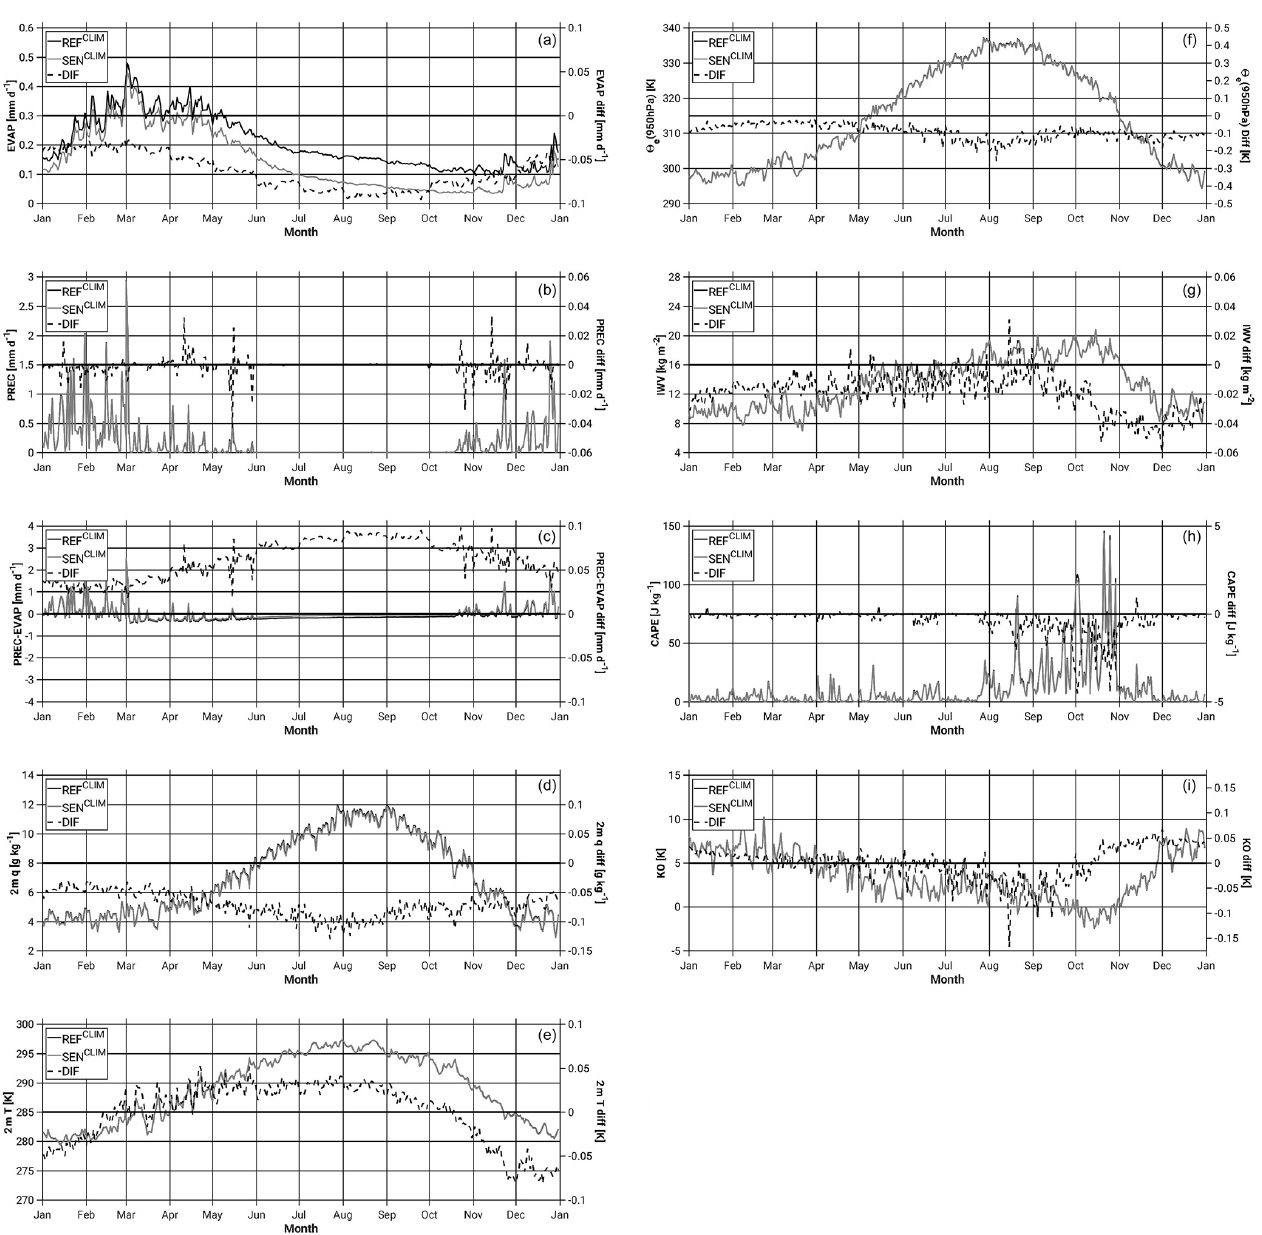
Figure 2. Annual cycle of the area-averaged daily accumulation of and differences in (black dashed line; SEN and REF) (a) evaporation, (b) precipitation, and (c) precipitation minus evaporation; (d) specific humidity and (e) temperature at 2m; (f) θ e below 950hPa; (g) IWV; (h) CAPE; and (i) KO index from the REF CLIM (full black line) and the SEN CLIM (full grey line) simulations. All grid points in the study area (Fig. 1) and the period 2004 to 2013 are